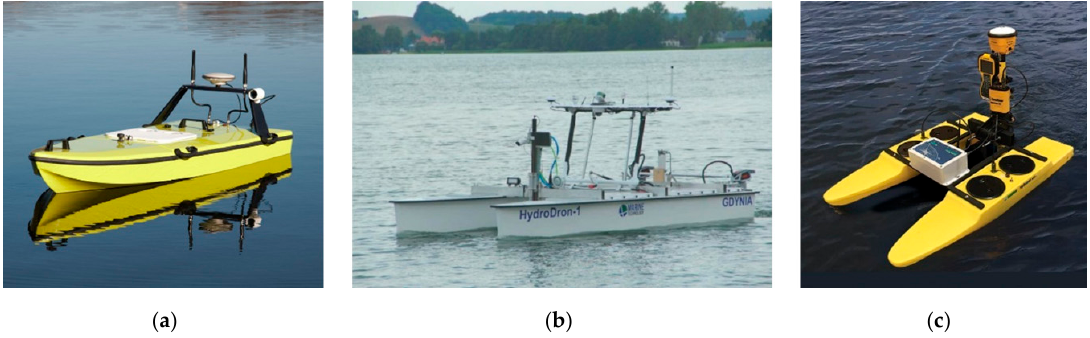
Figure1. Hydrographicunmannedsurfacevessels. Asingle-hulledCEE-USVvessel( a ), adouble-hulled Figure 1. Hydrographic unmanned surface vessels. A single-hulled CEE-USV vessel ( a ), a HydroDron ( b ), and a Seafloor Systems vessel ( c double-hulled HydroDron ( b ), and a Seafloor Systems vessel ( c ).